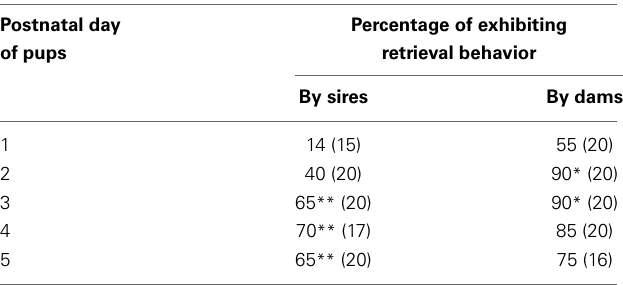
Table 2 | Percentages of sire’s or dam’s exhibiting retrieval behavior during the postpartum period.